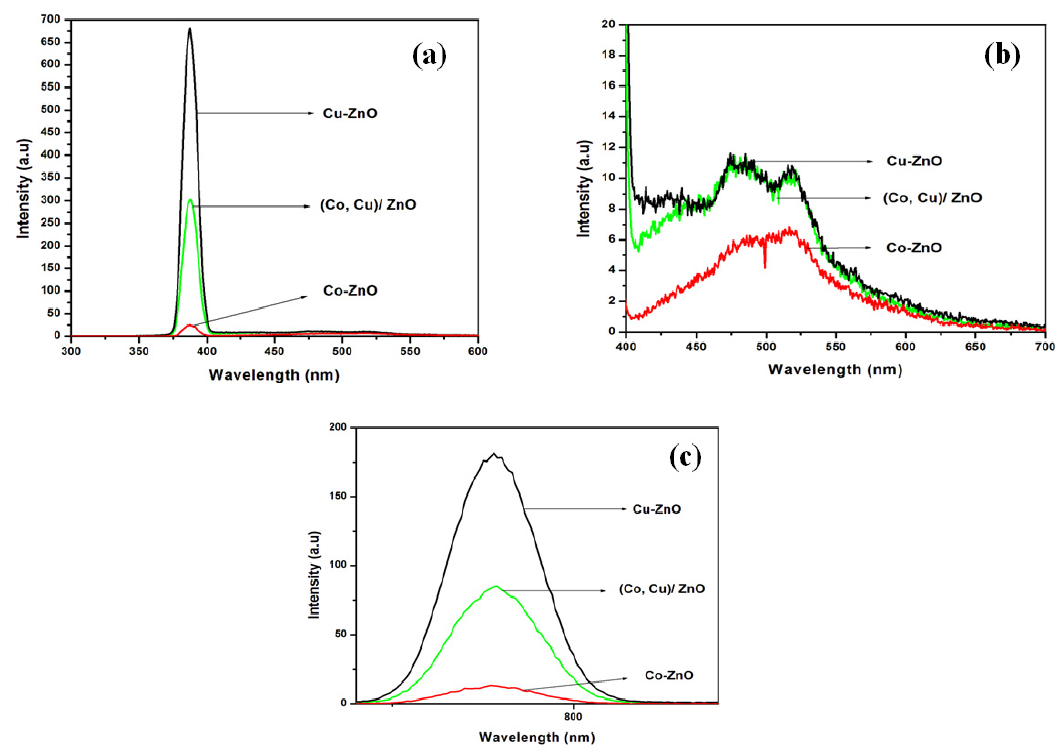
Fig. 5. PL spectra of ZnO, Cu-ZnO, Co-ZnO and (Co, Cu)/ZnO nanoparticles at (a) 385nm; (b) 520 nm; (c) 790